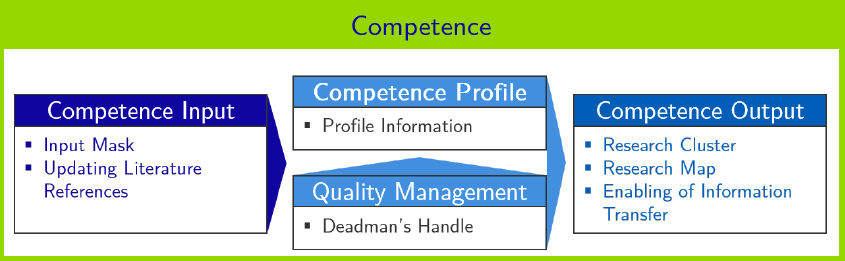
Figure 2. Overview of the grouped functionalities of Competence